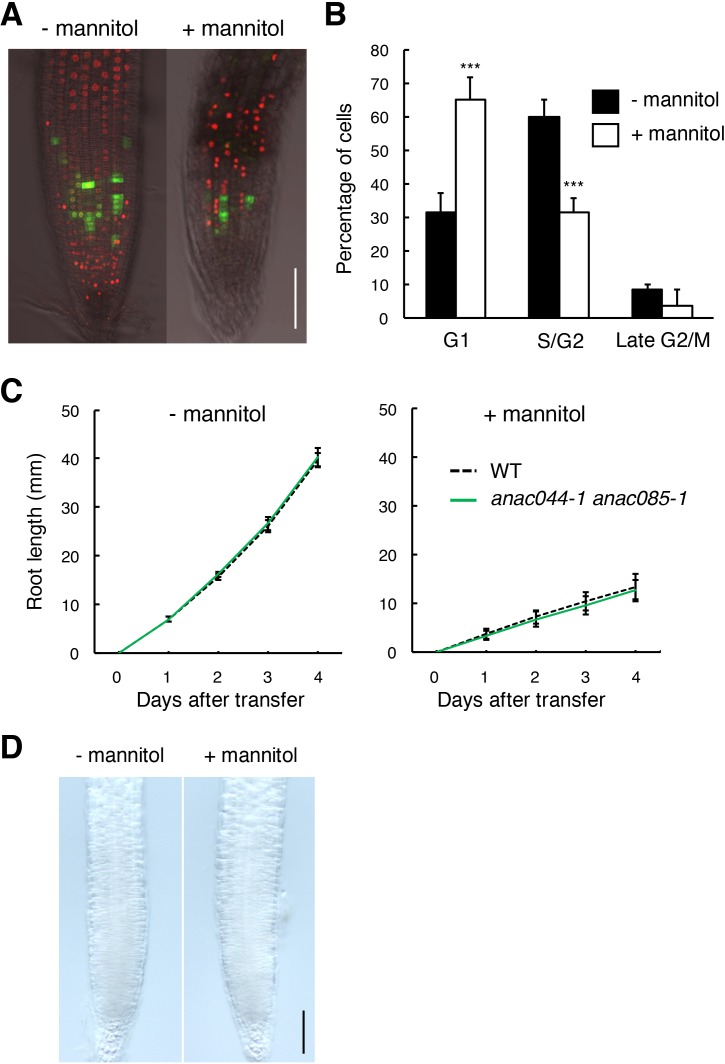
ANAC044 and ANAC085 are not involved in the osmotic stress response.(A, B) Omotic stress-induced cell cycle arrest in the root tip. Five-day-old seedlings carrying the cell cycle marker system Cytrap were transferred to medium supplemented with or without 400 mM mannitol, and grown for 24 hr. Signals of ProHTR2:CDT1a (C3)-RFP (S/G2 marker; red) and ProCYCB1;1:CYCB1;1-GFP (late G2/M marker; green) were observed (A). Bar = 100 µm. Cells with RFP or GFP signals were estimated to be in S/G2 or late G2/M, respectively, and those with no fluorescence were counted as G1-phase cells (B). Data are presented as mean ± SD (n = 10). Significant differences from the control without mannitol treatment were determined by Student’s t-test: ***, p<0.001. (C) Root growth of WT and anac044-1 anac085-1 under osmotic stress. Five-day-old seedlings were transferred to medium supplemented with or without 400 mM mannitol, and root length was measured every 24 hr. Data are presented as mean ± SD (n > 15). (D) GUS staining of roots harbouring ProANAC044:GUS. Five-day-old seedlings were transferred to medium supplemented with or without 400 mM mannitol, and grown for 24 hr, followed by GUS staining. Bar = 100 µm.10.7554/eLife.43944.032Figure 8—figure supplement 1—source data 1.Source data.